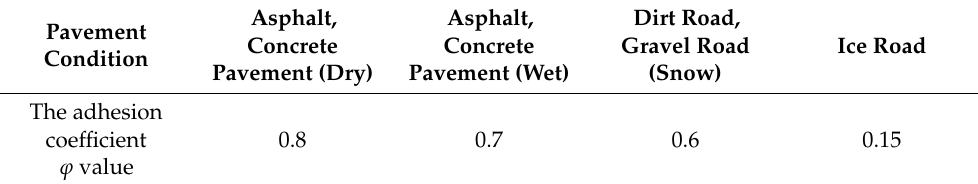
Table 1. Wheel–road adhesion coefficient ( ϕ ) values.